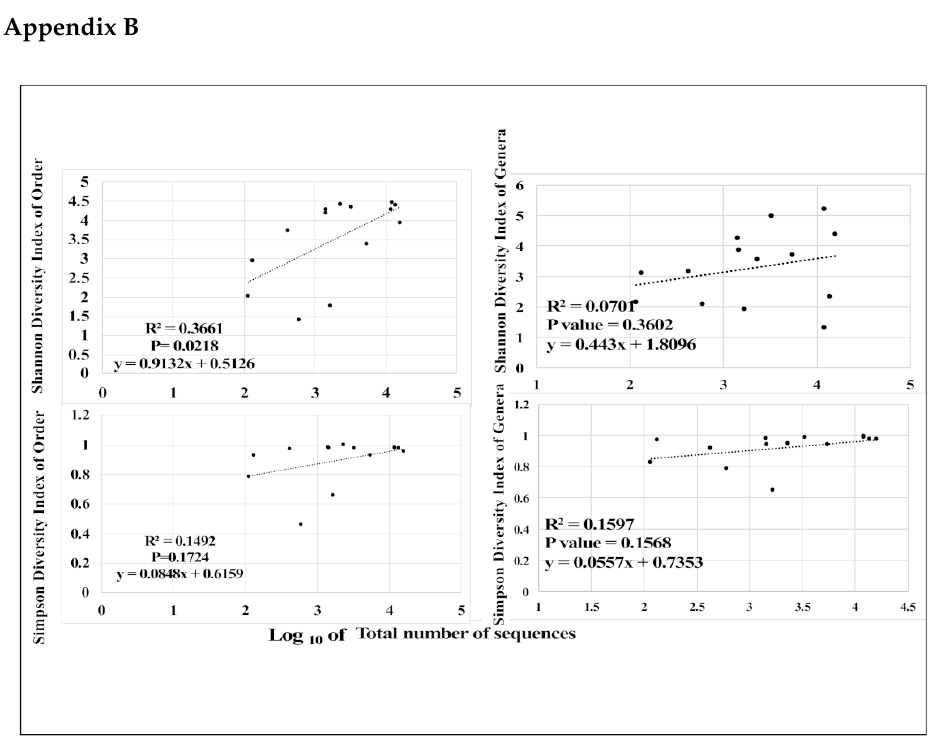
Figure A1. Scatterplot and line of fit for the Shannon and Simpson diversity indices of order and genera identified by 16S rRNA gene sequencing in samples from wetland sites 1–6. Sequence numbers are shown as Log 10